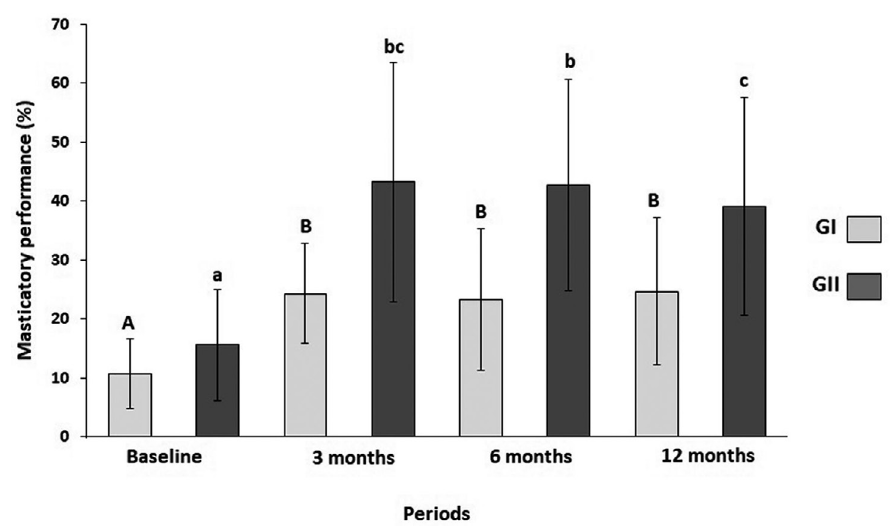
Figure 8- Masticatory performance among GI and GII participants